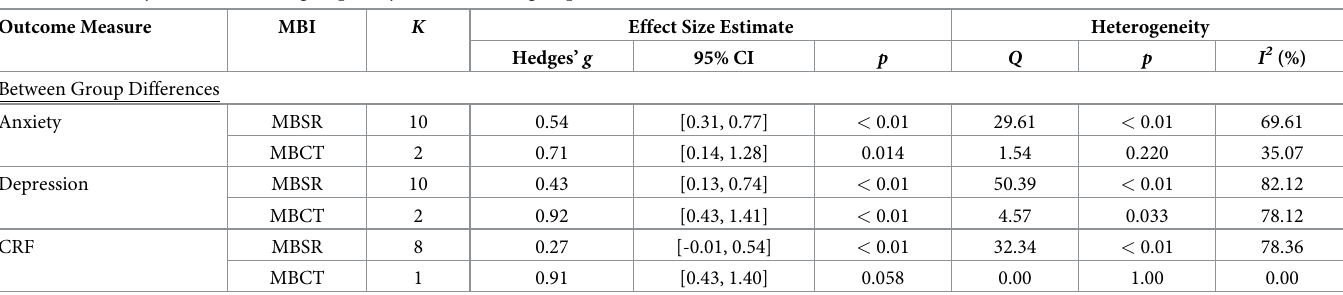
Table 5. Summary of the overall subgroup analyses for between group effect